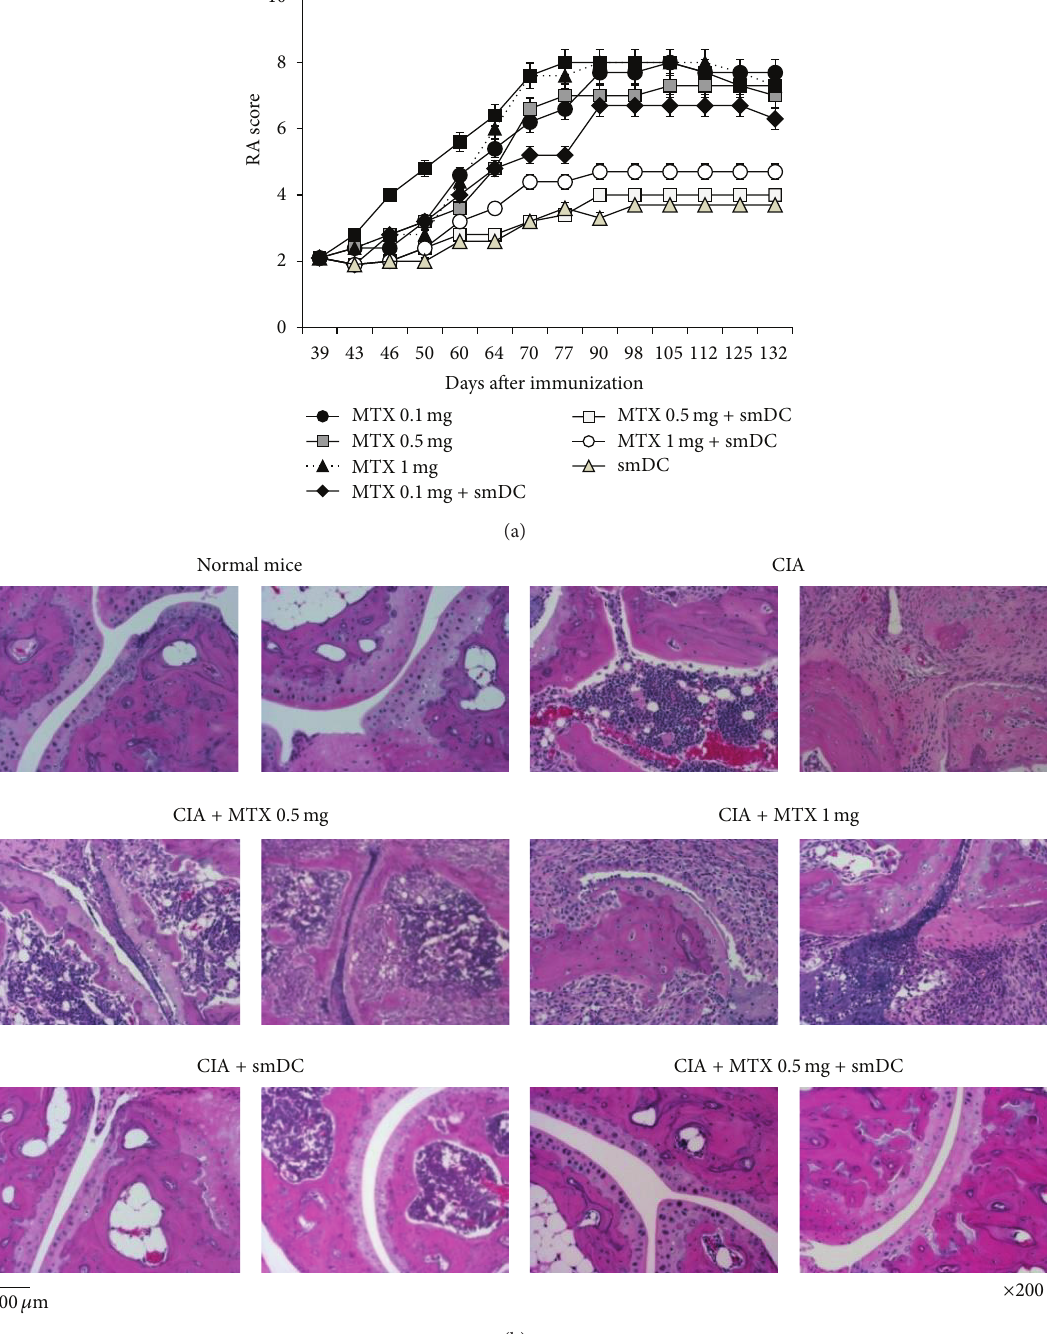
Figure 2: Treatment of advanced CIA mice with smDCs alone or in combination with MTX. (a) DBA/1J mice were injected with CFA-mixed type II collagen (CII) on days 0 and 21. Advanced CIA mice (RA score 2 ∼ 3) were then treated with smDC and/or MTX for 2 weeks. Disease progression was monitored for 132 days. (b) Histological analysis of the hind paws. Hind paws were removed from mice in all groups at day 77 after first CII injection and fixed in paraffin blocks. Histopathology was examined after H&E staining as described in Section